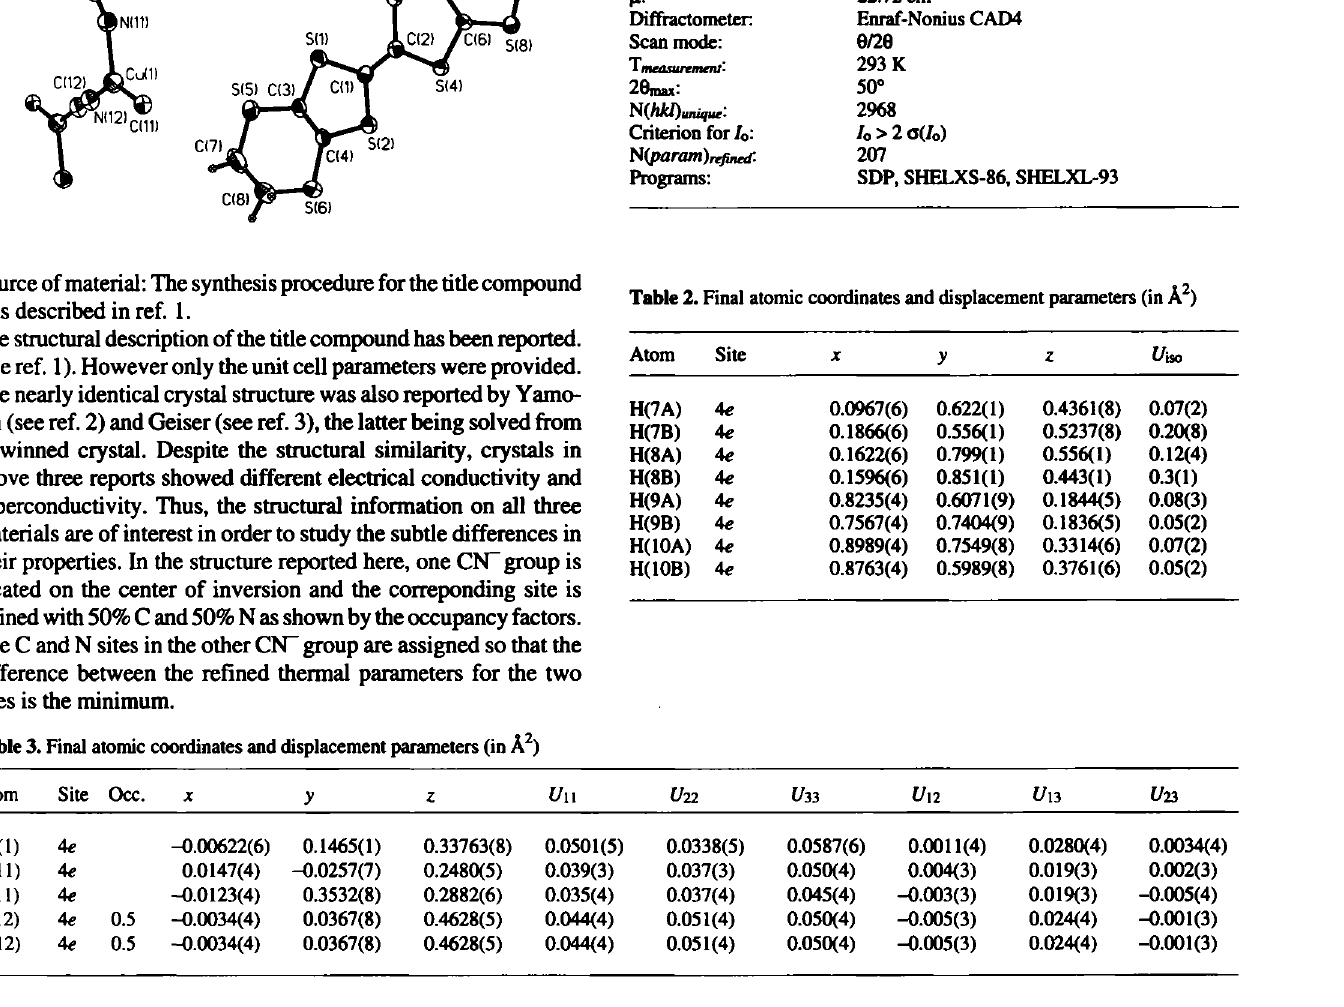
Table 1. Parameters used for the X-ray data collection Crystal: